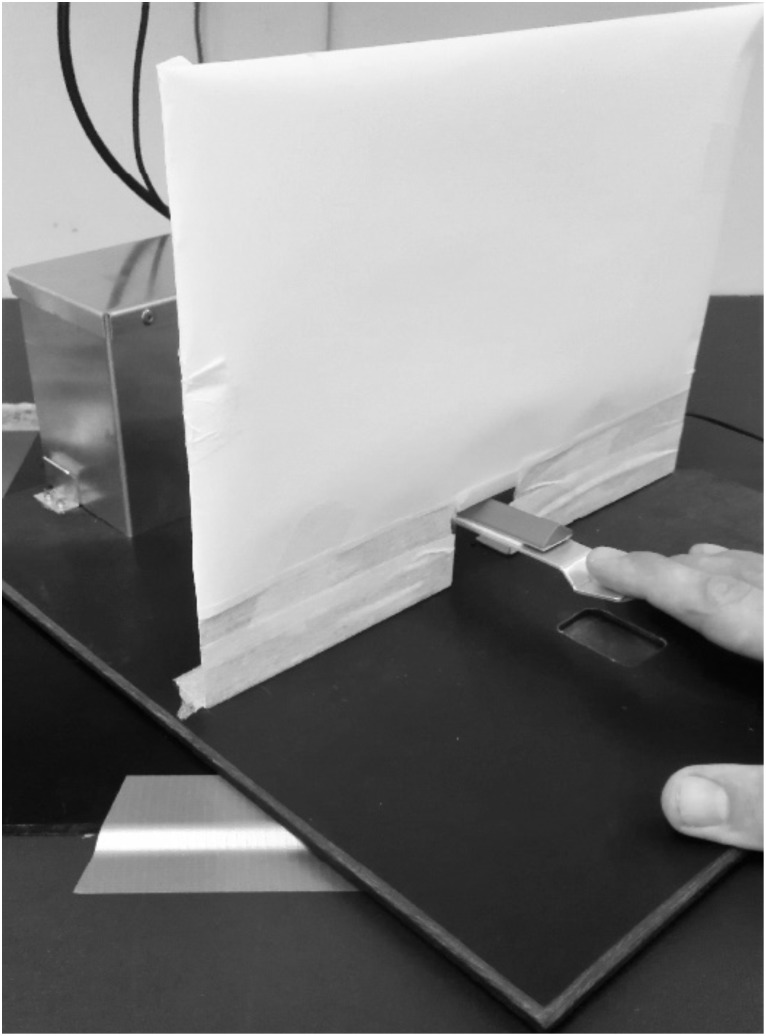
Illustration of the custom-built passive tapping machine.